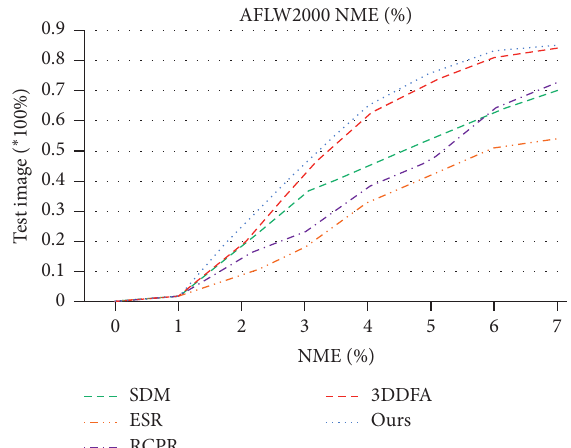
Figure 6: Comparisons of cumulative errors distribution (CED) curves on AFLW2000.